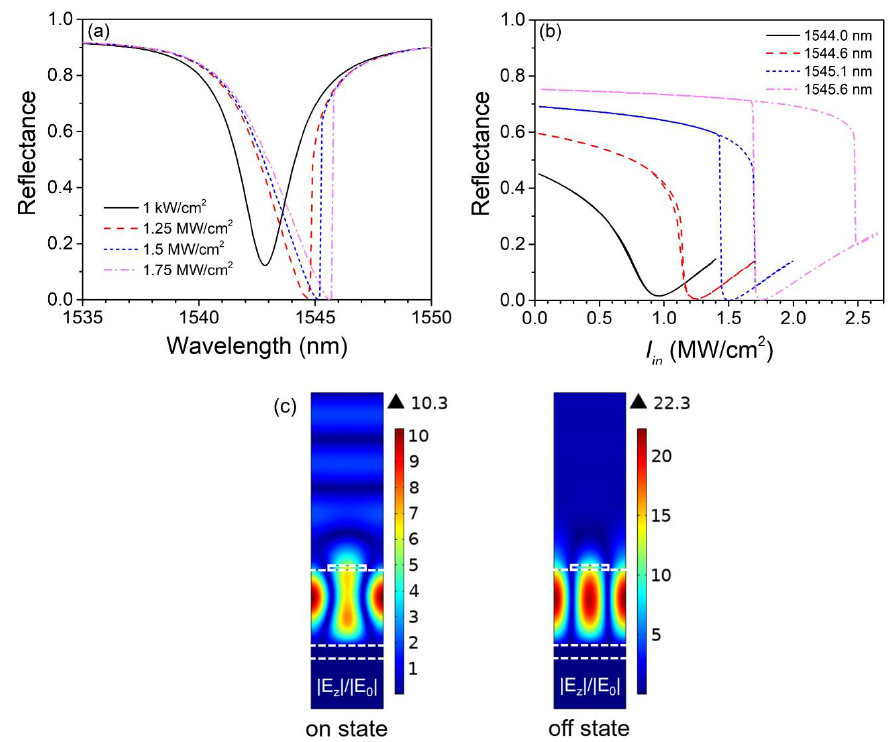
Figure 3. ( a ) Nonlinear reflectance spectrums at different incident intensities. ( b ) Hysteresis loops of reflectance at different working wavelengths. ( c ) Distribution of normalized electric field at the on and off states at 1545.6 nm, with I in = 1.75 MW/cm 2 .